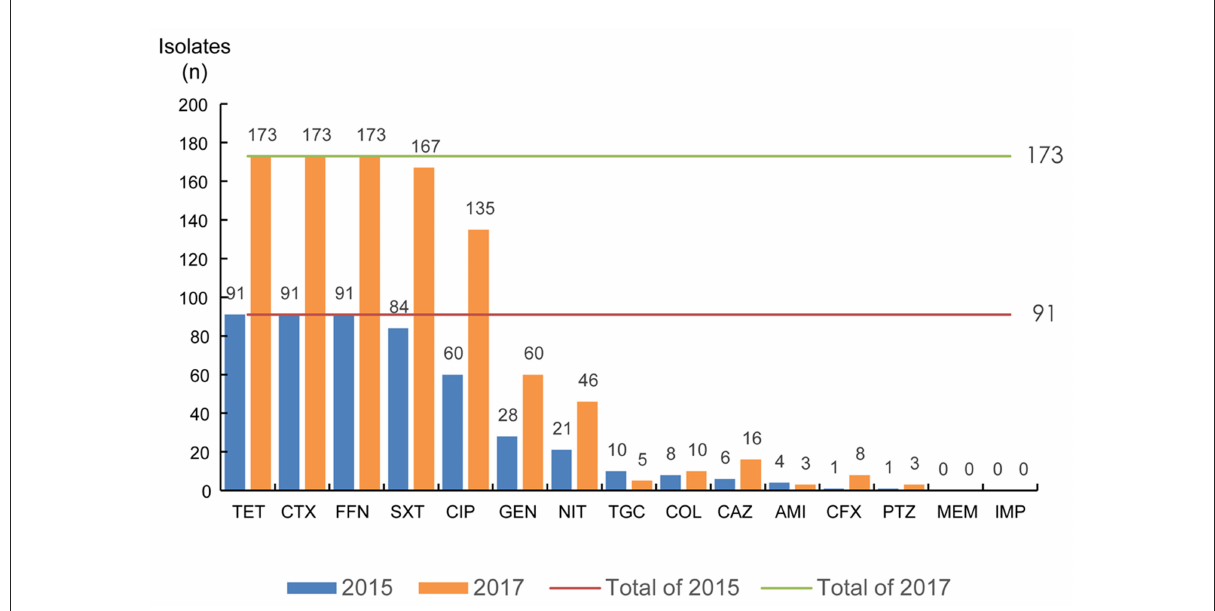
FIGURE2 The antimicrobial susceptibility of ESBLs-producing K. pneumoniae. TET, tetracycline; CTX, cefotaxime; FFN, florfenicol; SXT, trimethoprim-sulfamethoxazole; CIP, ciprofloxacin; GEN, gentamicin; NIT, furantoin; TGC, tigecycline; COL, colistin; CAZ, ceftazidime; AMI, amikacin; CFX, cefoxitin; PTZ, piperacillin-tazobactam; MEM, meropenem; IMP, imipenem.